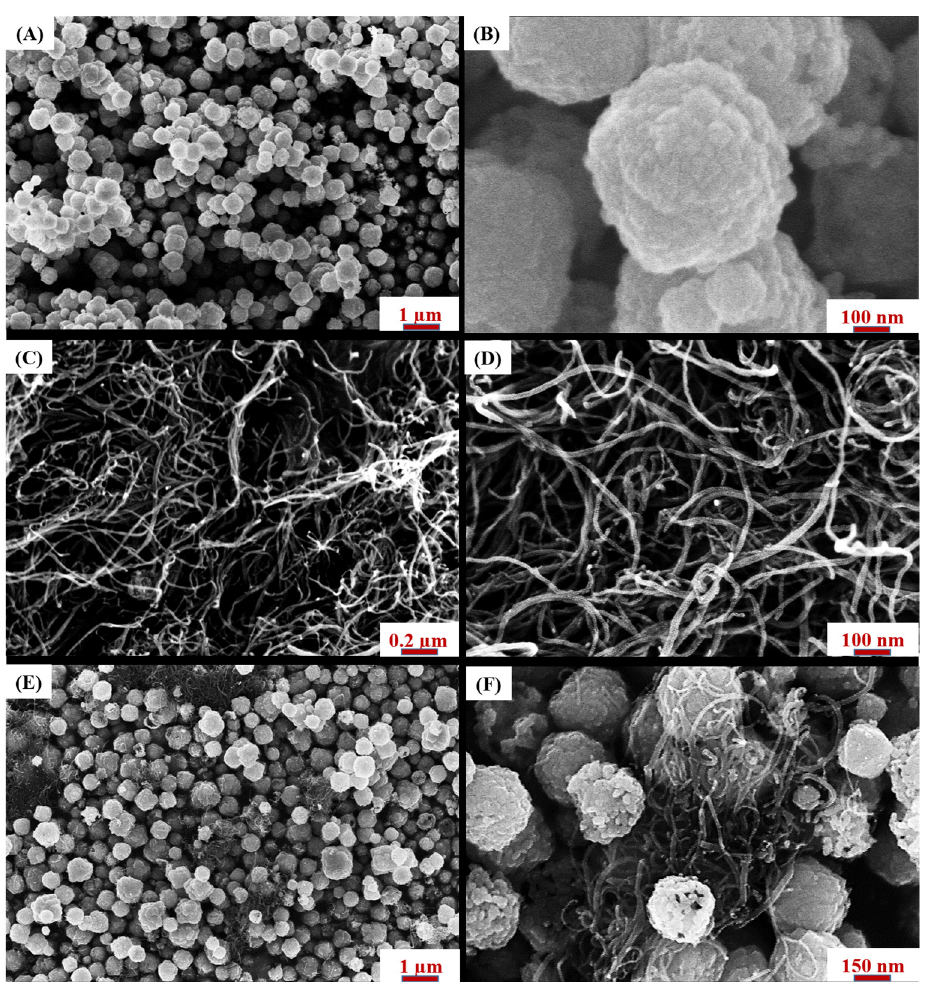
Figure 2. SEM: ( A , B ) CuO nanoparticles; ( C , D ) fCNTs; ( E , F ) AgCuO NPs/fCNTs.